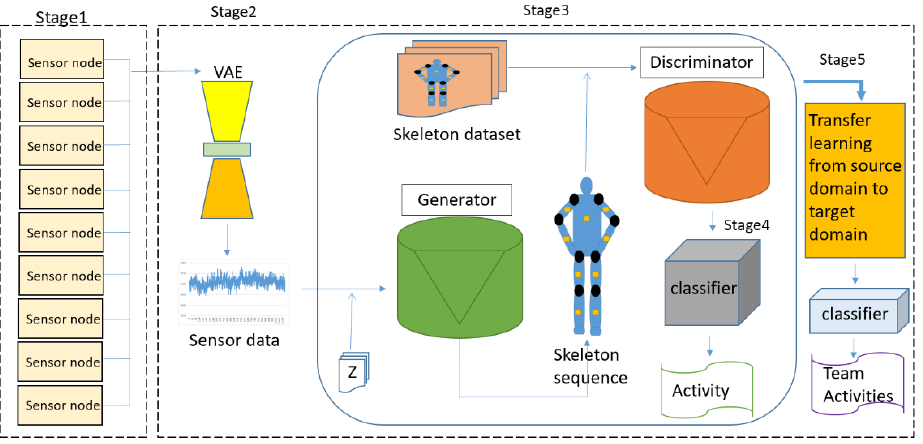
Figure 1. The proposed DNN architecture on HAR.